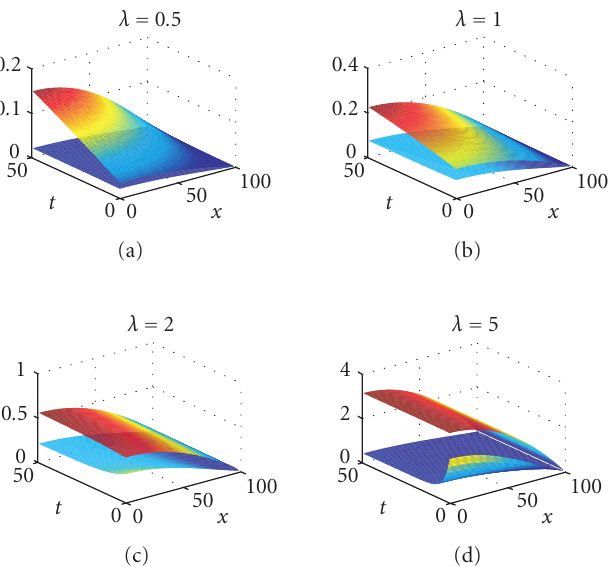
Figure 4.3. Upper and lower bounds for the cylindrical geometry, when β = 0 . 5, δ = 0 . 1, and λ = 0 . 5,1,2,5.